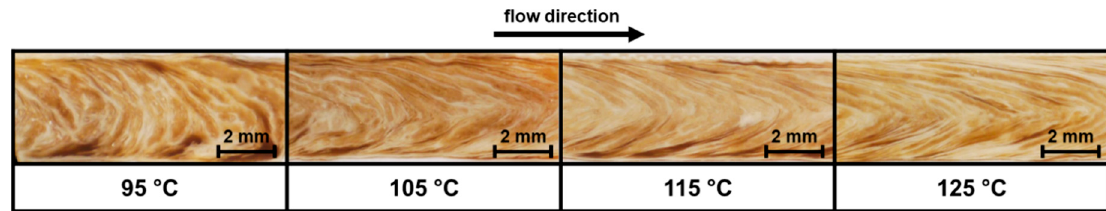
Figure 5. Morphology of the extrudates at the four different material temperatures obtained via cryo-imaging. Flow direction is from left to right; lateral view displayed.